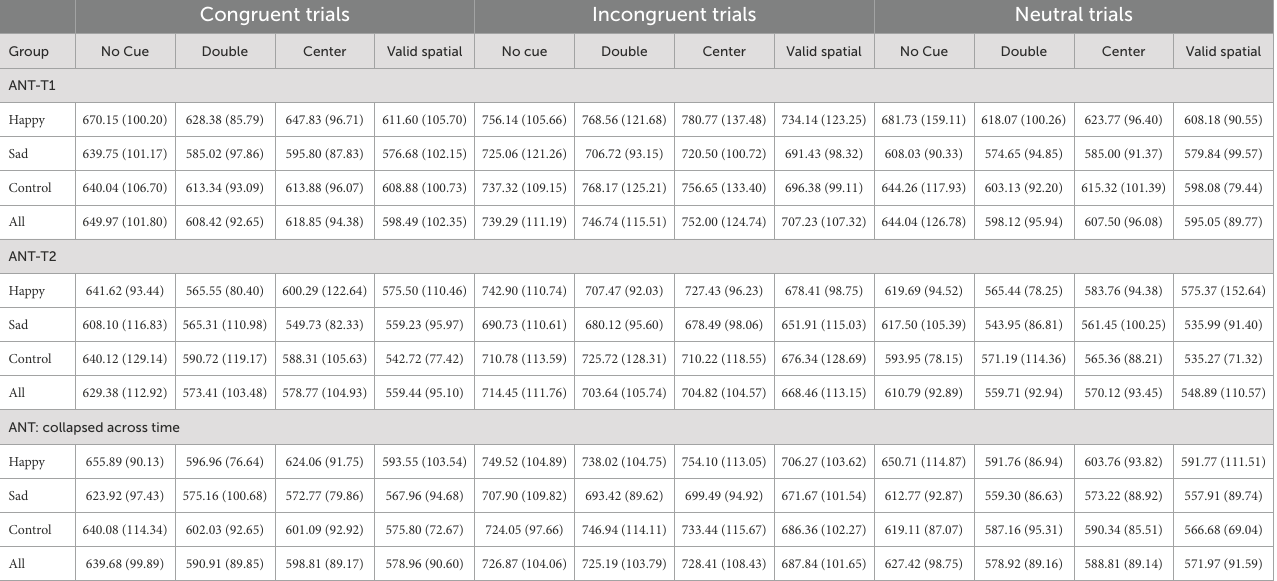
TABLE 3 The means and standard deviations (in parentheses) for the ANT separated by time, group, congruency, and